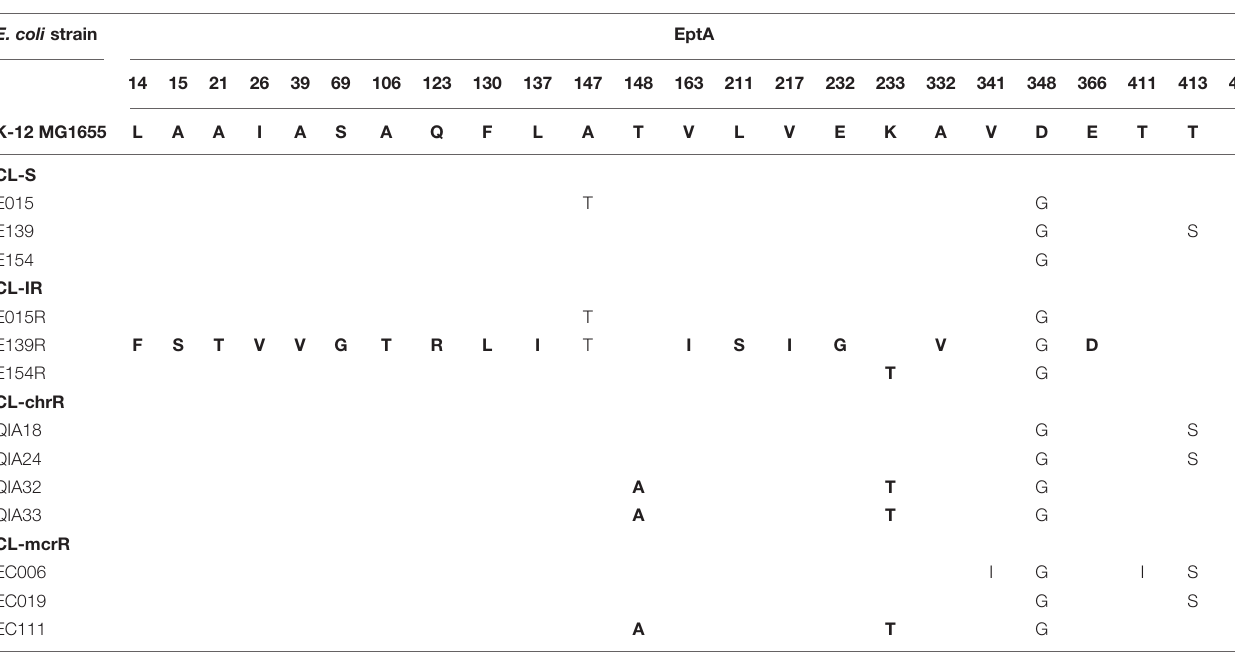
a Amino acid alterations found only in colistin-resistant strains are indicated in